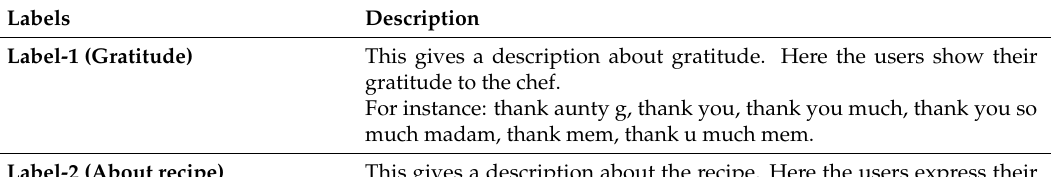
Table 2. Categories of